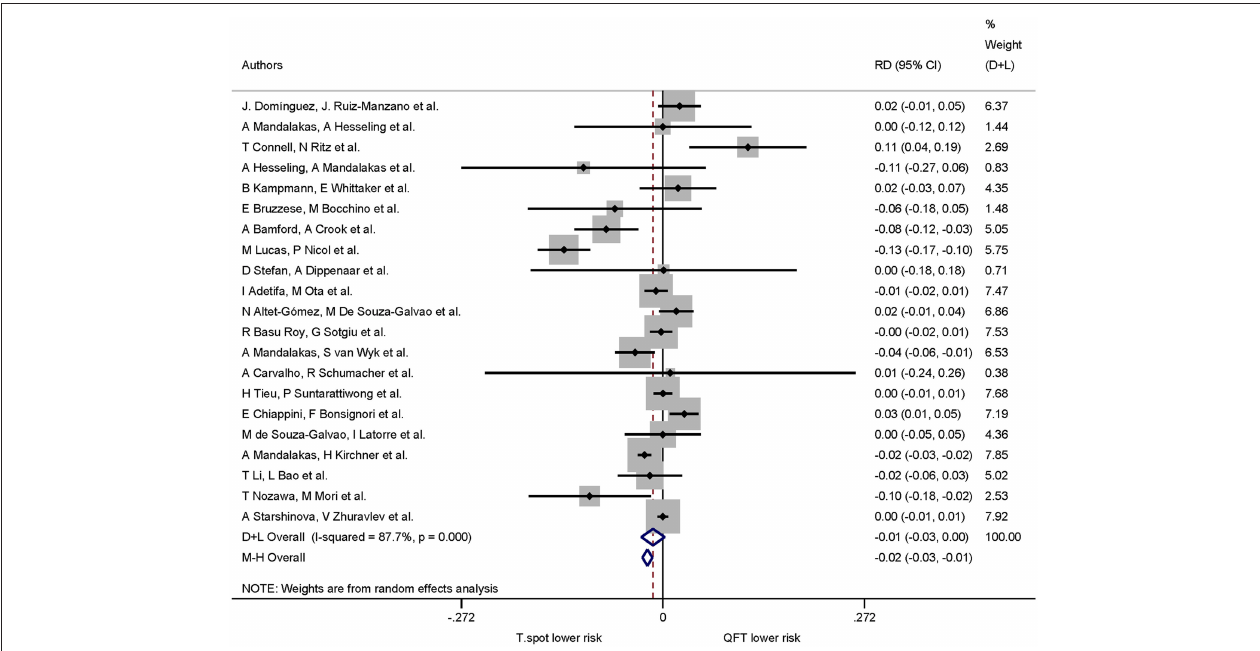
FIGURE 3 | Risk difference (RD) with 95% CI in studies that included a head-to-head comparison of QuantiFERON-TB and T-SPOT.TB assays. Studies arranged according to year of publication.